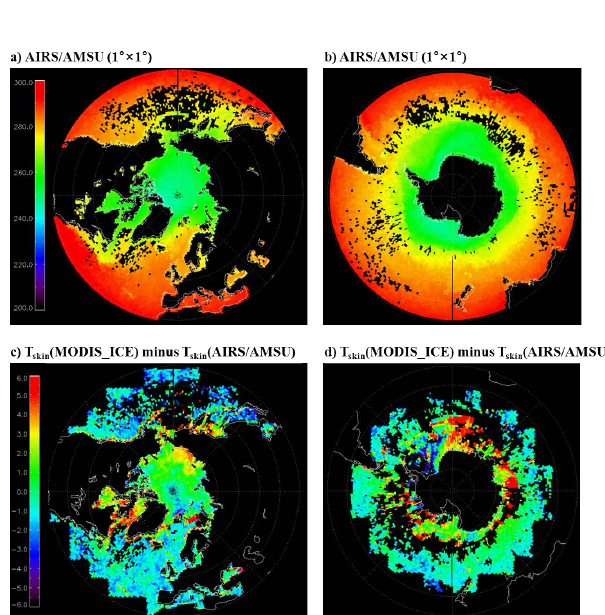
Fig. A2. 9-day composite surface skin temperature (K) of AIRS/AMSU over the (a) Northern Hemisphere during the days 106–114, 2003, and (b) Southern Hemisphere during the days 258–266, 2003, (c) and (d) the difference between T skin (MODIS_ICE) and T skin (AIRS/AMSU).